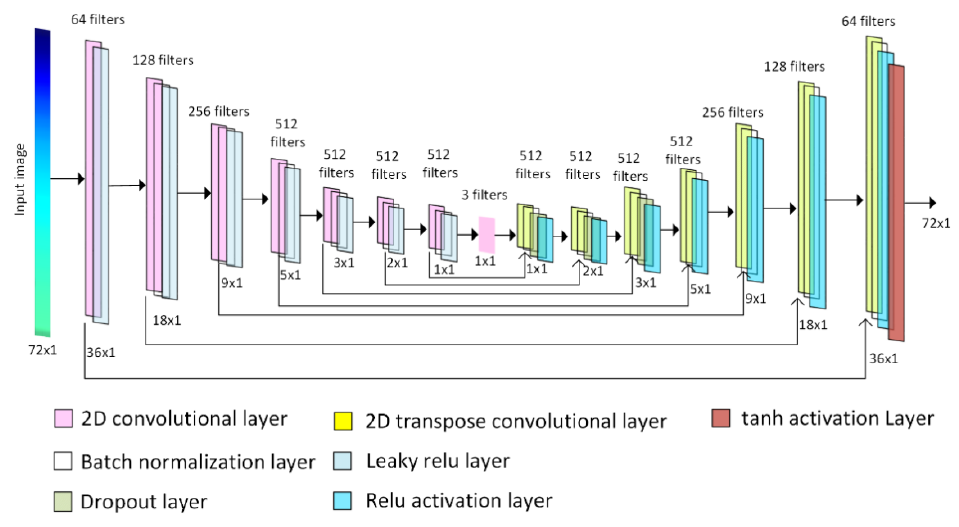
Figure 4. The U-Net generator model used to generate novel plausible BG images.